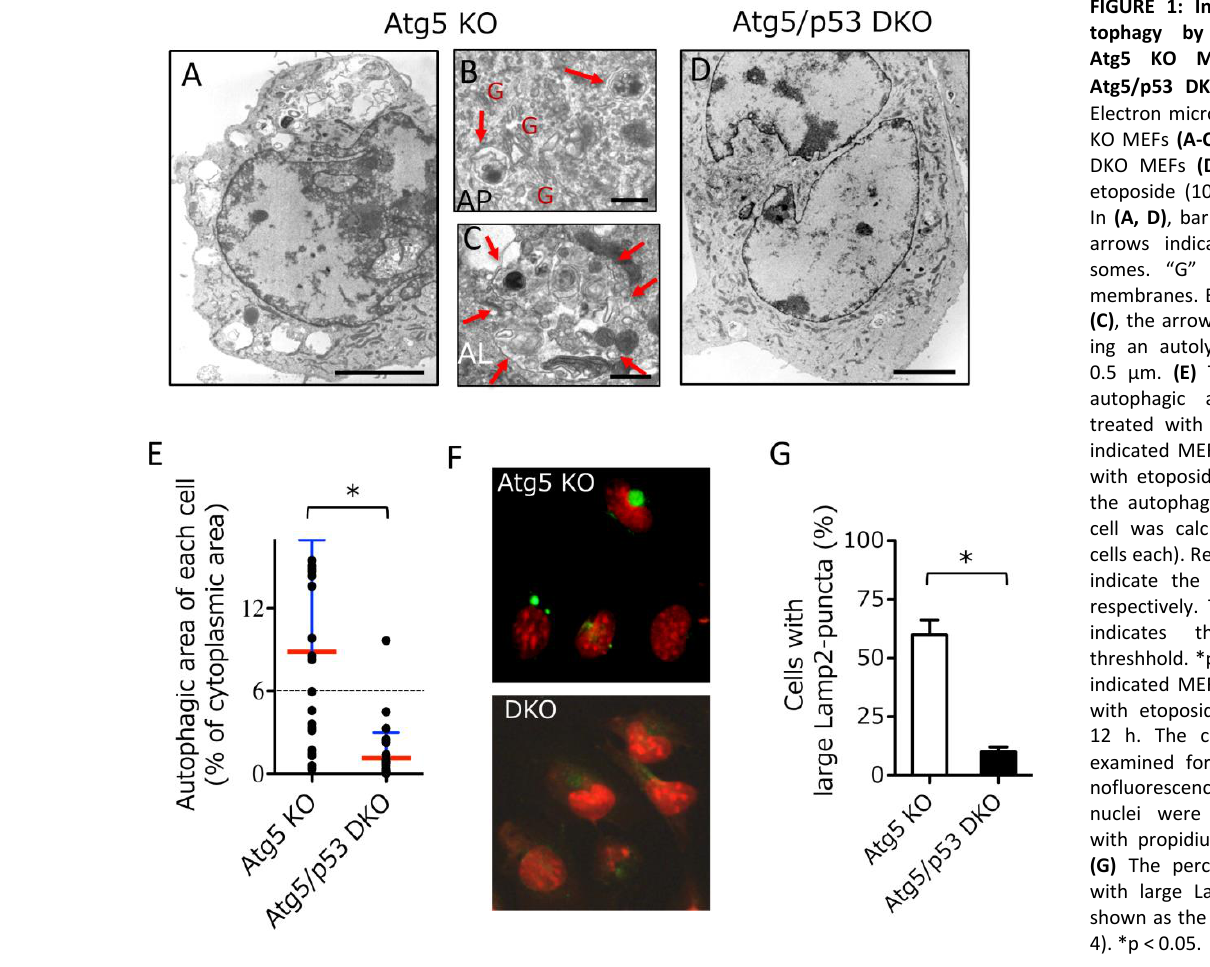
FIGURE 1: Induction of au- tophagy by etoposide in Atg5 KO MEFs, but not Atg5/p53 DKO MEFs. (A-D ) Electron micrographs of Atg5 KO MEFs (A-C) and Atg5/p53 DKO MEFs (D) treated with etoposide (10 µM) for 18 h. In (A, D) , bar = 5 µm. In (B) , arrows indicate autophago- somes. “G” indicates Golgi membranes. Bar = 0.5 µm. In (C) , the arrows are surround- ing an autolysosome. Bar = 0.5 µm. (E) The percentage autophagic area of MEFs treated with etoposide. The indicated MEFs were treated